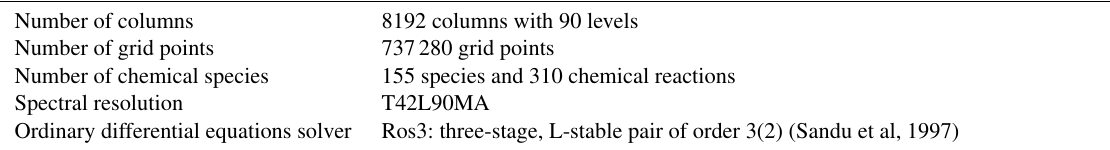
Table 1. Hardware configurations used for performance evaluation. Node CPU No. of RAM Accelerators Peak performance cores GB NVIDIA GPU Cores DELL ® dx360 JURECA node Xeon E5-2680 v3